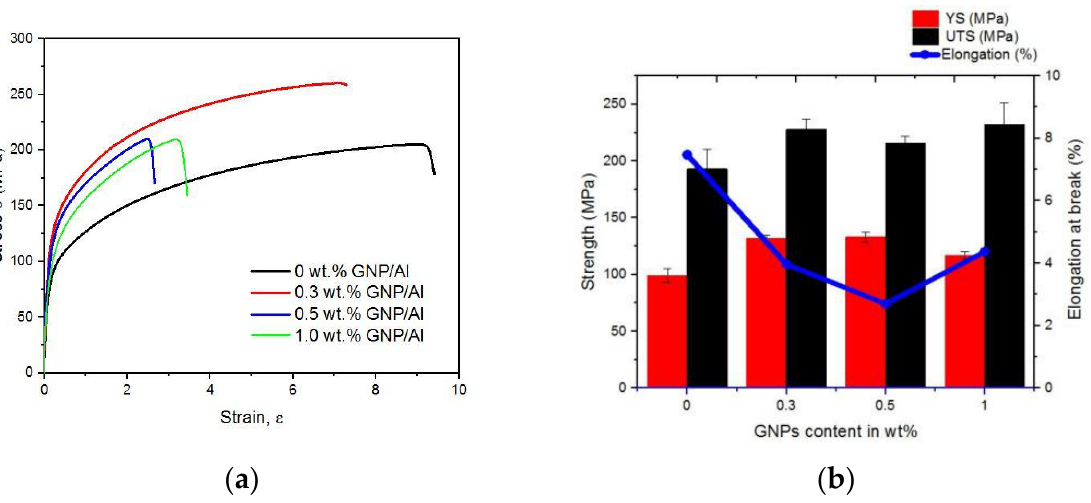
Figure 9. Comparison of the hardness of alloy and composite with different compositions.